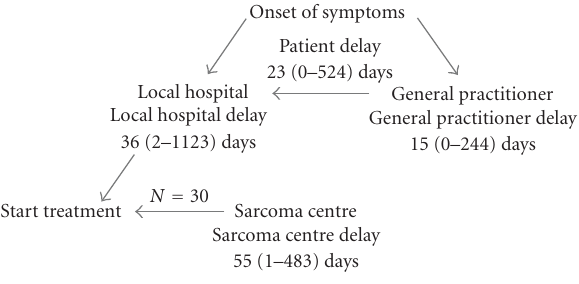
Figure 1: Overview of the di ff erent median lead times.